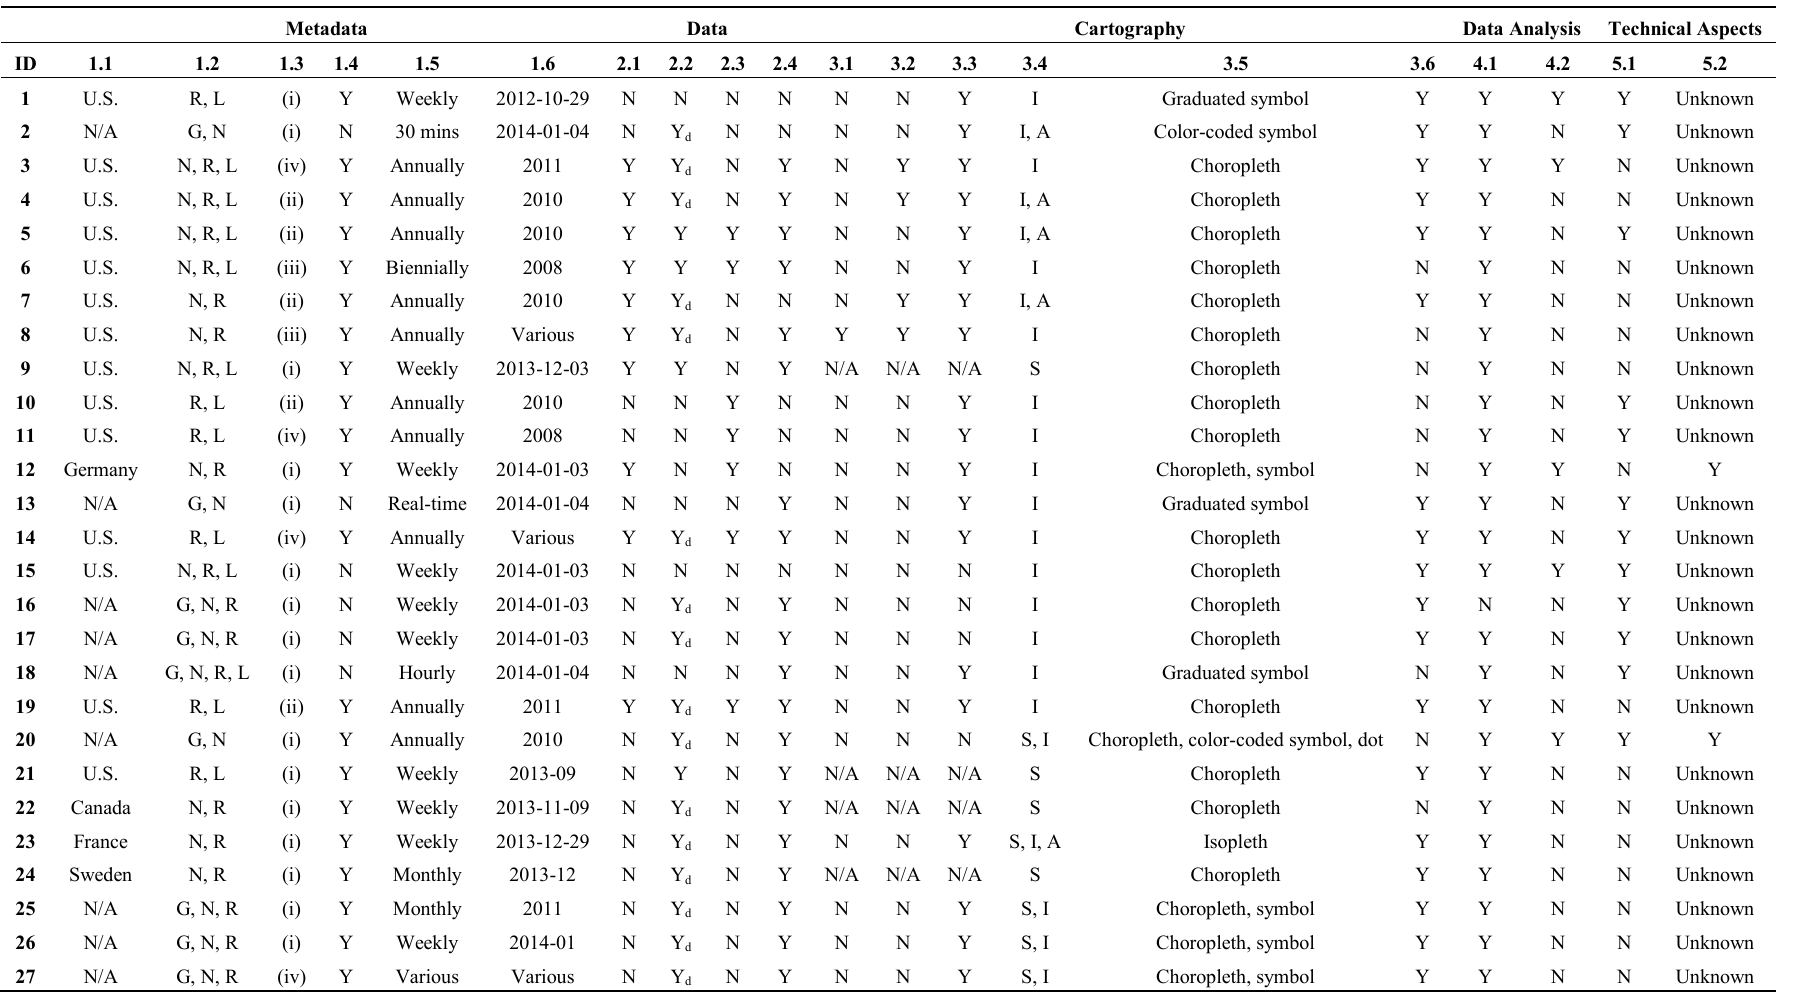
Table 3. Results of analysis of the 27 eligible